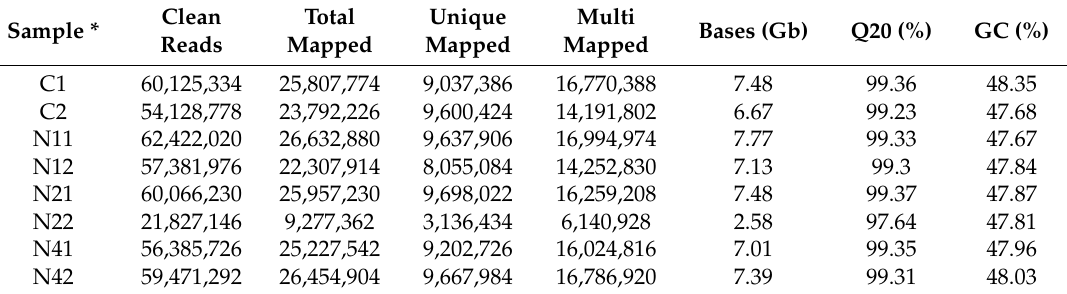
Table 1. Summary of data generated in the transcriptome sequencing of